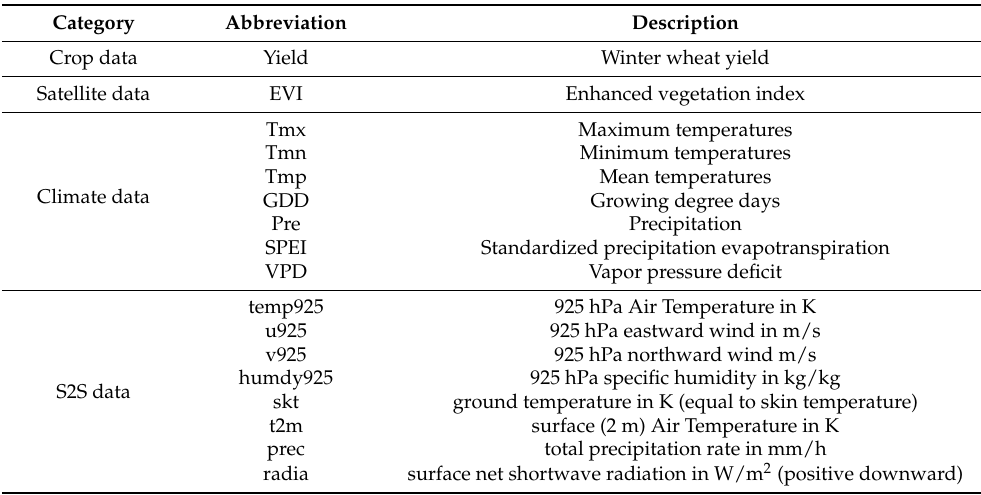
Table 1. Summary and abbreviations of input data.